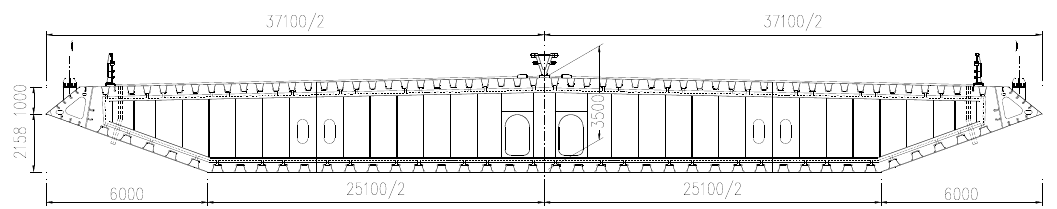
Figure 3. Cross-section of girder (Unit: mm).